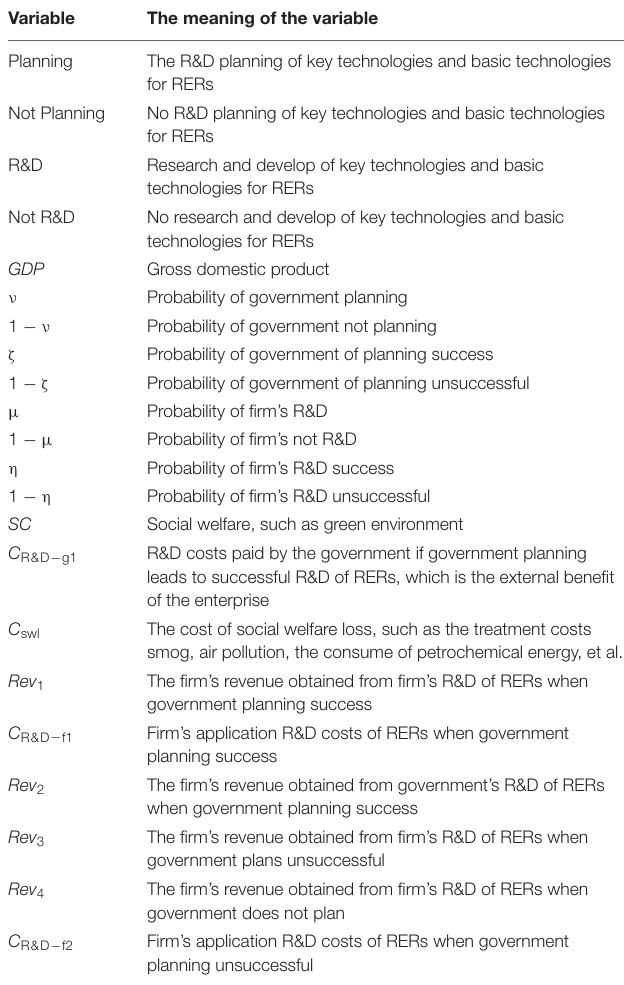
TABLE 4 | The meaning of variables and